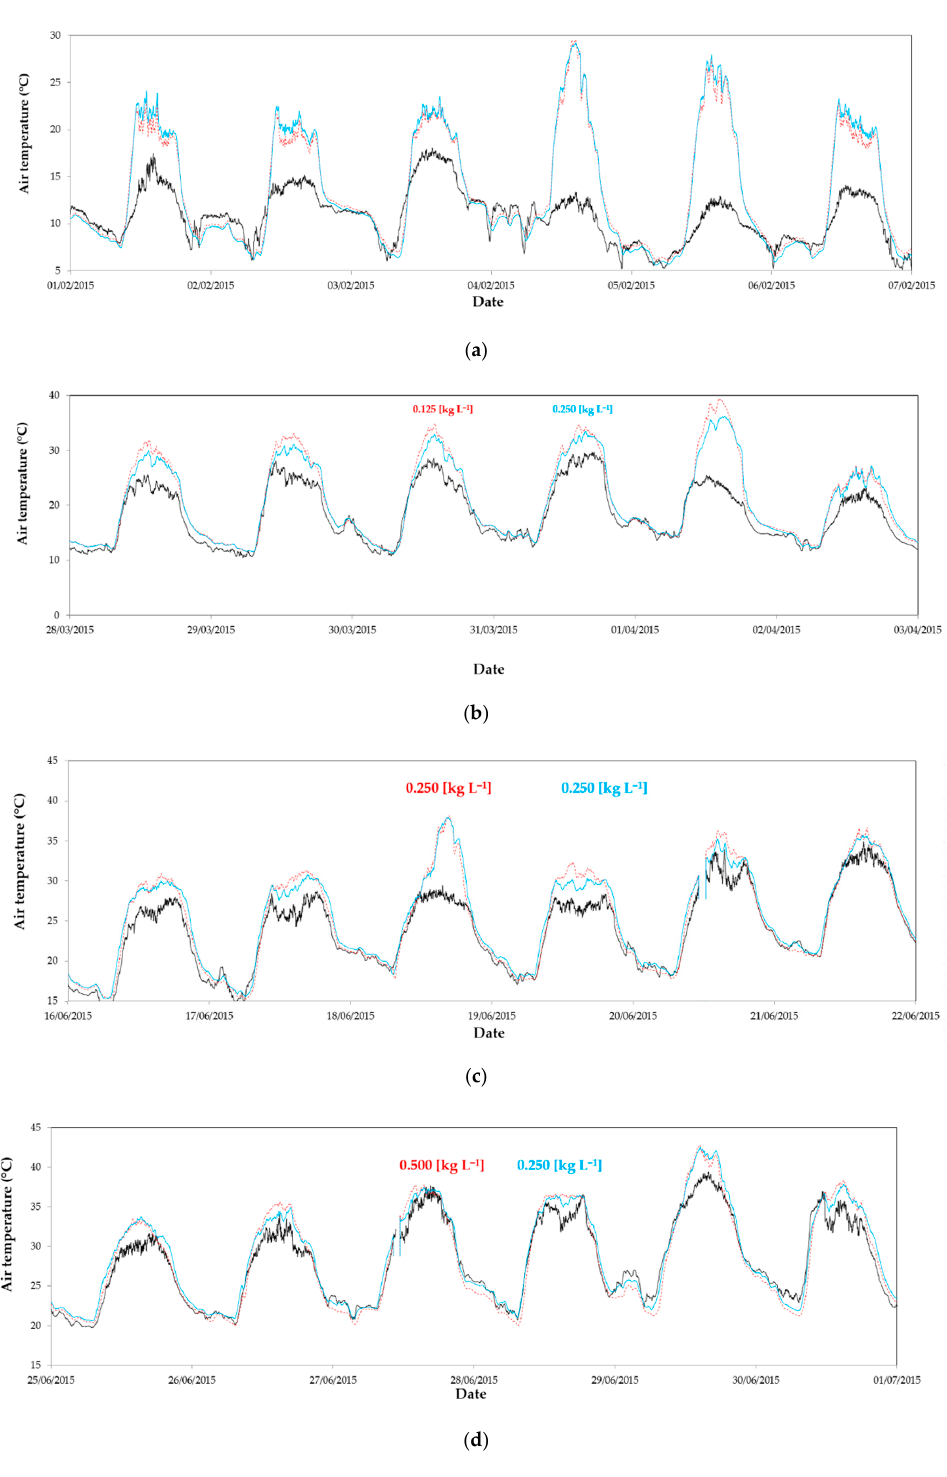
Figure 5. Evolution of air temperature outside (—-) and inside greenhouse 1 (at 1 m height) in the east sector ( ····· ) and the west sector (—-): ( a ) from 1 to 7 February 2015 without whitening in both sectors; ( b ) from 28 March 2015 to 3 April 2015 with a concentration of 0.125 kg L − 1 in the east and 0.250 kg L − 1 in the west; ( c ) from 16 to 22 June 2015 with a concentration of 0.250 kg L − 1 in both sectors; ( d ) from 25 June 2015 to 1 July 2015 with a concentration of 0.500 kg L − 1 in the east and 0.250 kg L − 1 in the